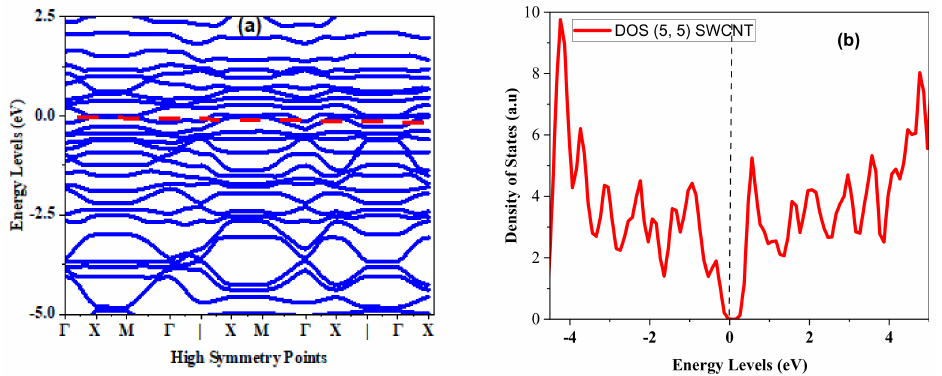
Figure 2. ( a ) The electronic bands and ( b ) density of the states of (5, 5)